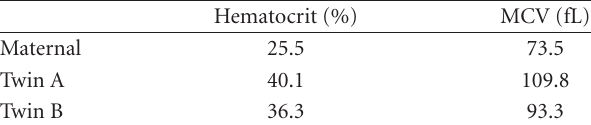
Table 1: Maternal and fetal hematocrit and MCV